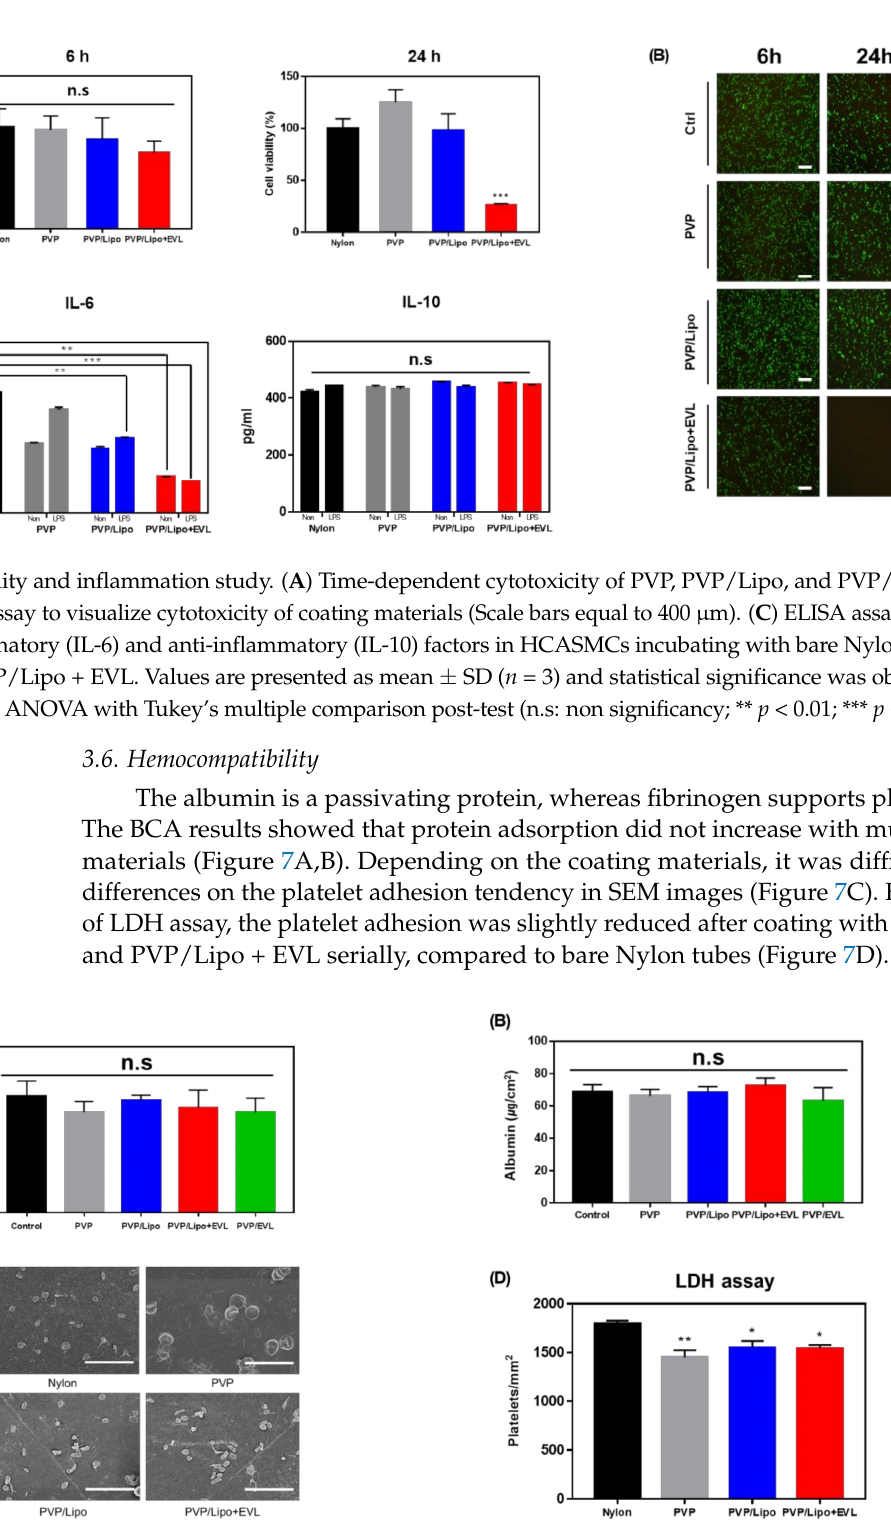
Figure 7. Hemocompatibility test. The degree of protein adsorption of ( A ) Fibrinogen and ( B ) Albumin depending on various coated layers (Control means bare Nylon tubes). ( C ) SEM images for platelet adhesion incubating with coated materials (Scale bars equal to 20 µ m). ( D ) LDH assay to evaluate platelet adhesion onto coated materials. Values are presented as mean ± SD ( n = 3) and statistical significance was obtained with one-way analysis of ANOVA with Tukey’s multiple comparison post-test (* p < 0.05; ** p <